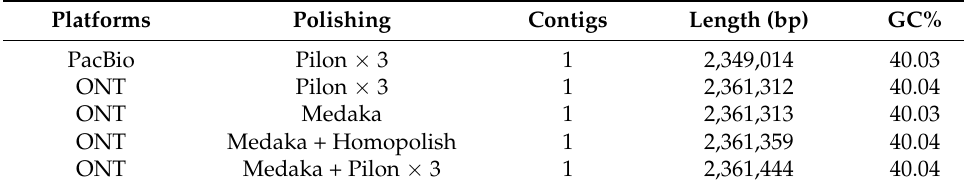
Table 3. Statistics of results of genome assembly with